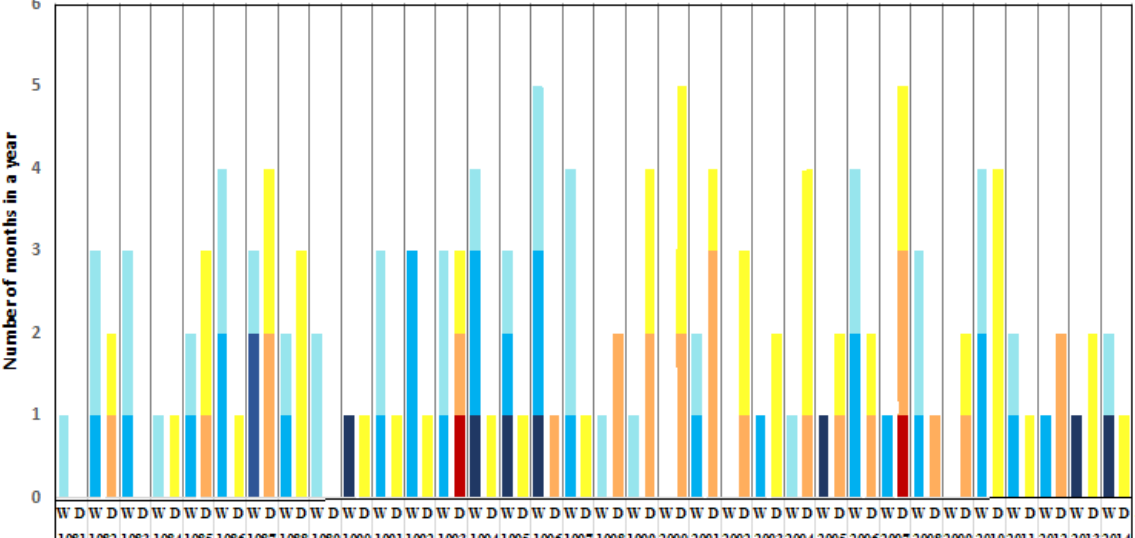
Figure 3. Annual variations in the number of months affected by wet–dry conditions during 1984–2014. The brown and blue colours present dry and wet months respectively. Different shades of the colours define the different severity levels (EW – extreme wet; ED – extreme dry; SW – severe wet; SD – severe dry; MW – moderate wet; MD – moderate dry).